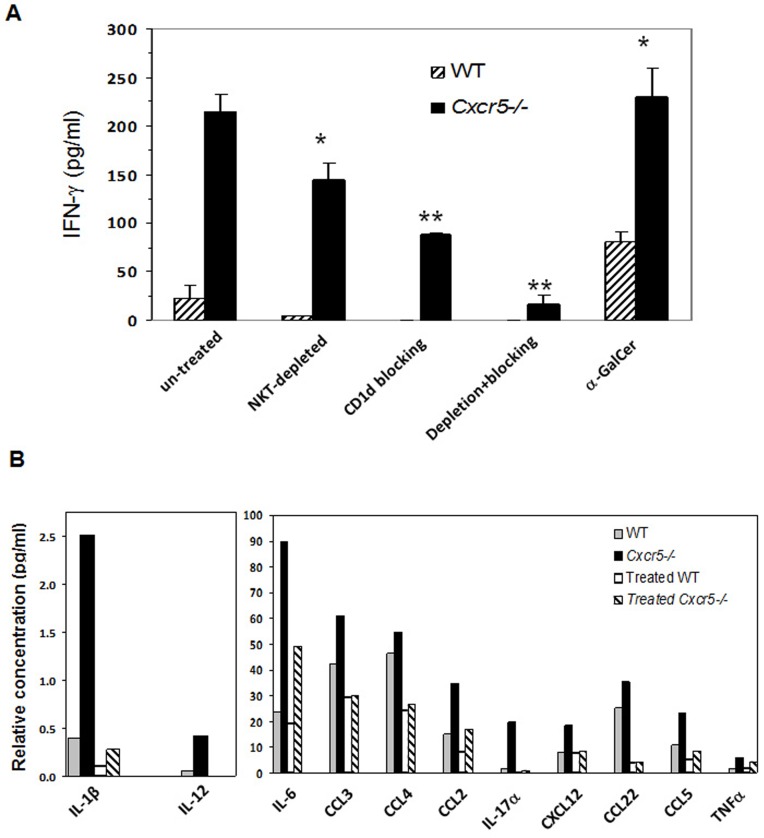
In vitro depletion of NKT cell function abrogates increased production of IFNγ and other cytokines and chemokines in Cxcr5−/−.Lymphocytes were isolated from spleens and treated with various conditions to deplete NKT cells to 95% purity. Cells were cultured with EB for 3 days. (A) The level of IFNγ in cell culture supernatants among groups with the indicated NKT cell depleting/blocking treatment. Each treated group was compared to its own untreated counterpart using Bonferroni's modified t test, *p<0.05, **p<0.01, n = 4 mice/group. (B) Multiple cytokines and chemokines levels were measured in supernatants from α-GalCer depleted plus anti-CD1d treated cell cultures (Depletion+blocking).